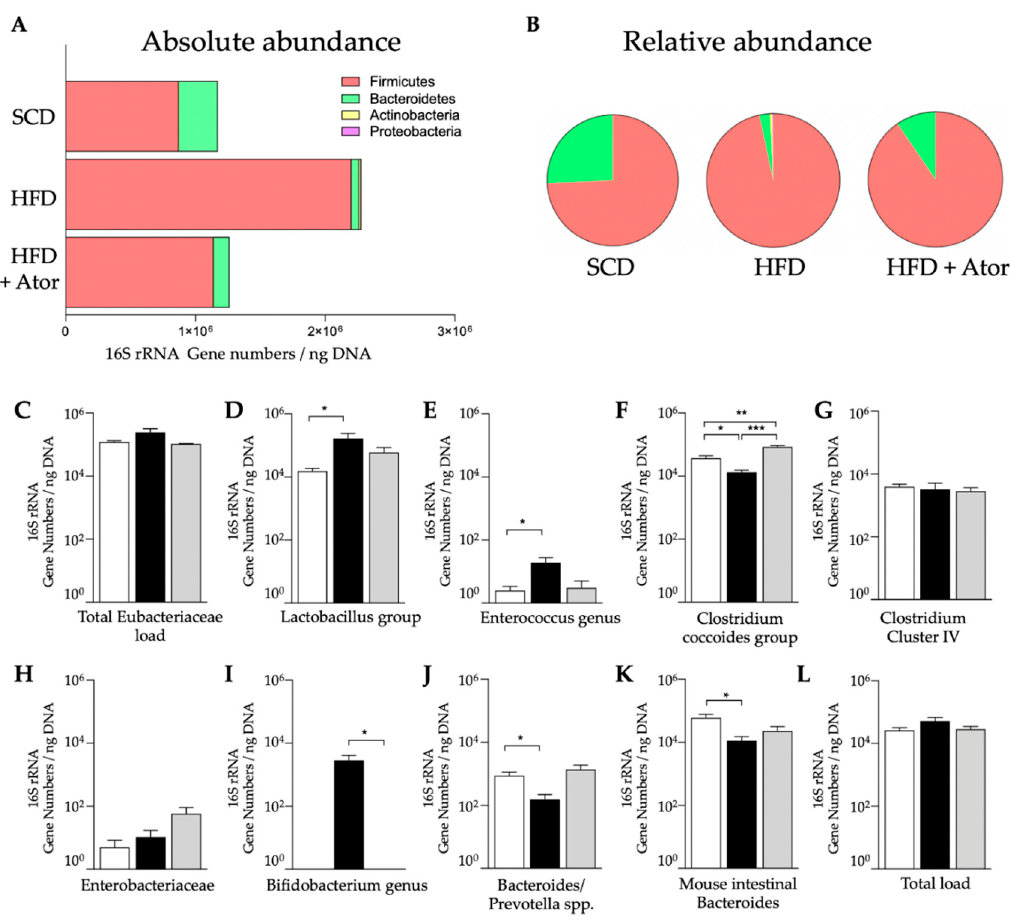
Figure 5. Analysis of intestinal microbiota. ( A , B ): Alterations of main intestinal bacterial phyla in response to HFD and the effects of Ator treatment ( n = 15). ( C – L ): Analysis of 16S rRNA gene copies of distinct bacterial groups ( n = 15). Error bars indicate SEM. * = p < 0.05, ** = p < 0.01; *** = p < 0.001.